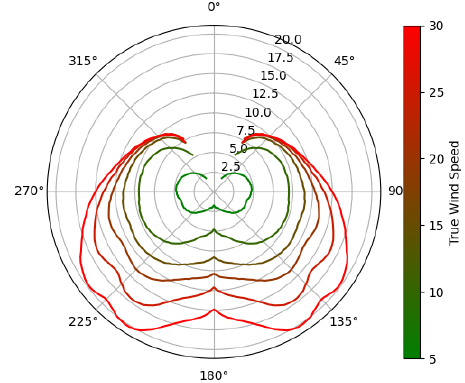
Figure 1. Example of a polar diagram as polar plot.